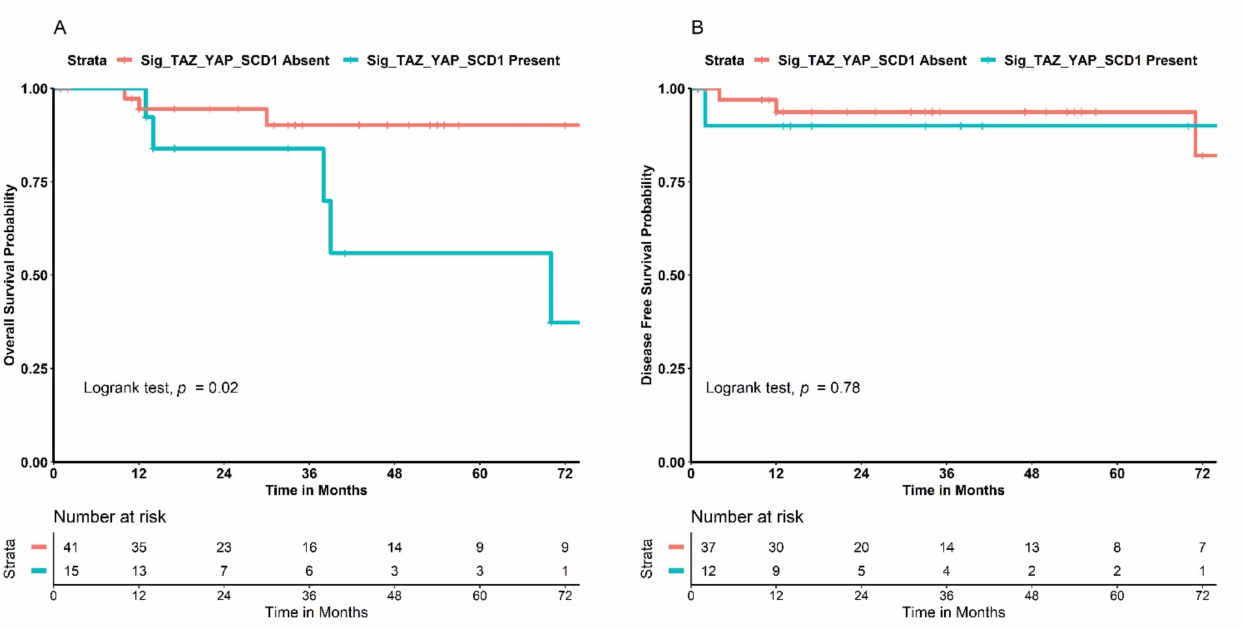
Figure 8. Validation of a similar signature to the one we identified on breast cancer patients from the Breast Invasive Carcinoma—TCGA, PanCancer dataset. ( A ) Kaplan–Meier curves and risk table displaying the comparison in terms of overall survival between patients with tumors with the signature “present” and those with tumors with the signature “absent”. ( B ) Kaplan–Meier curves and risk table displaying the comparison in terms of disease-free survival between patients with tumors with the signature “present” and those with tumors with the signature “absent”. Abbreviations: SCD1